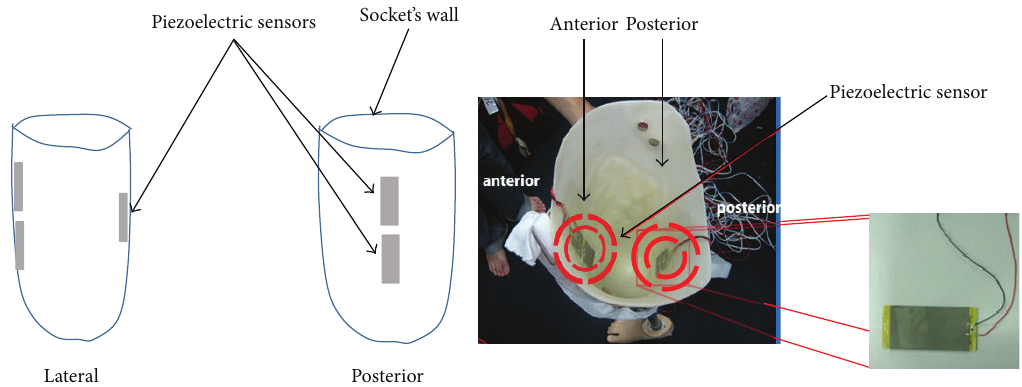
Figure 3: Placement of the piezoelectric sensors at both anterior and posterior